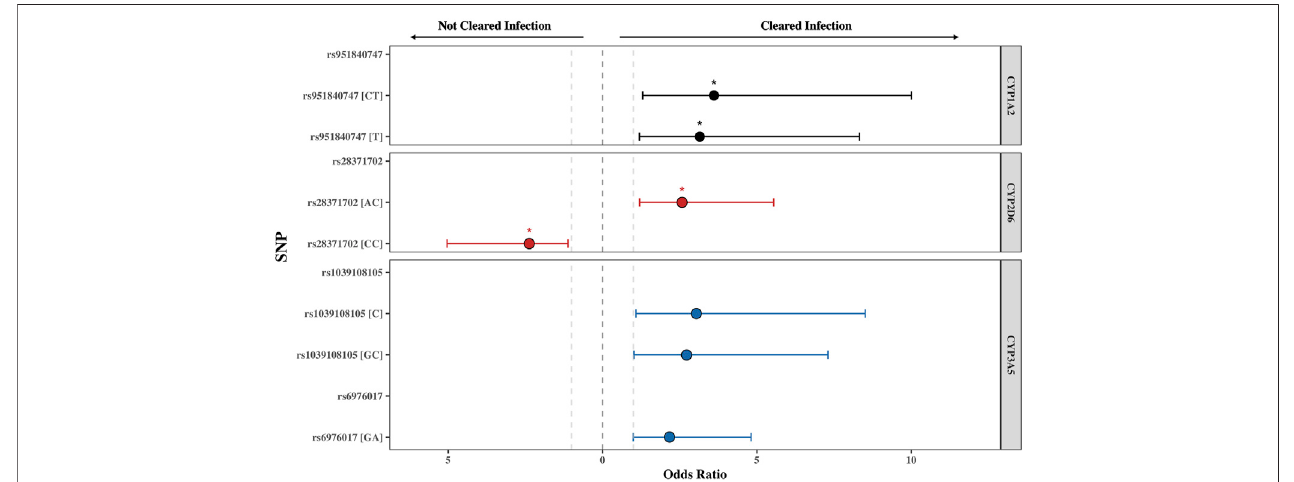
FIGURE 2 | The odds ratio (OR) of the single nucleotide polymorphisms (SNPs) found to be signi fi cantly associated with PZQ ef fi cacy for CYP1A2, CYP2D6 , and CYP3A5 .Thethresholdforsigni fi cance wassetat p ≤ 0.05,withthe*indicating a P adj ≤ 0.05obtained from χ 2 Yates test representinganadjusted p -value accountingfora continuity correction. All SNPs displayed were below this threshold. The grey lines represent OR= 1, representing no impact ofthe SNP on PZQ ef fi cacy. The error bars illustrate the 95% con fi dence interval. The genotype or allele of each SNP is displayed in parentheses, illustrating whether the OR represents the allelic, heterozygous genotype, or homozygous genotype for the alternate allele.